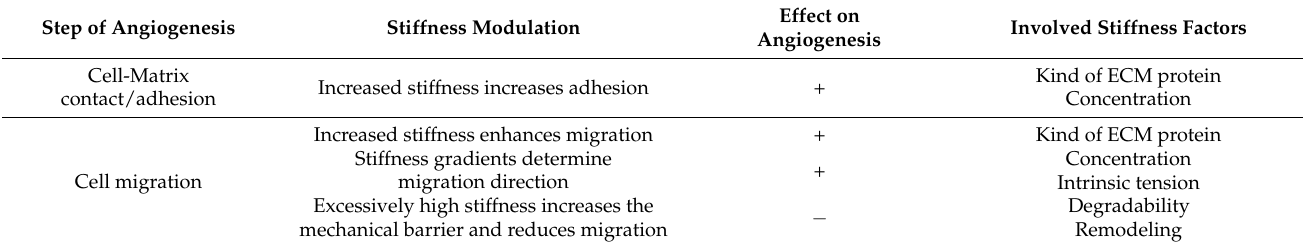
Table 2. Effect of stiffness modulation on the different steps of angiogenesis. (+ = increased angiogenesis, − = decreased